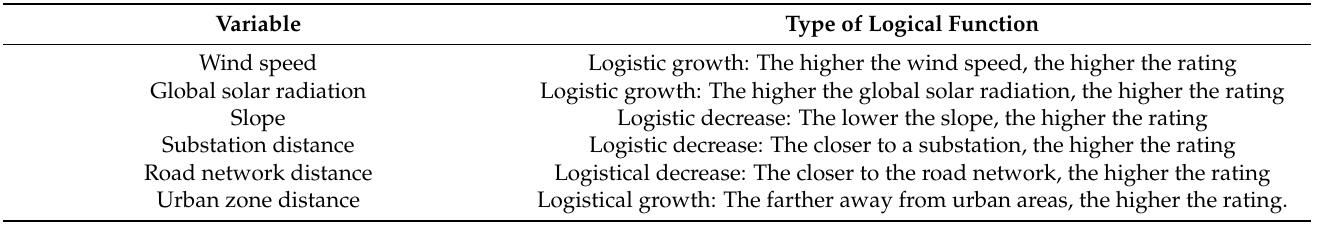
Table 3. Functions applied to re-scaled variables.